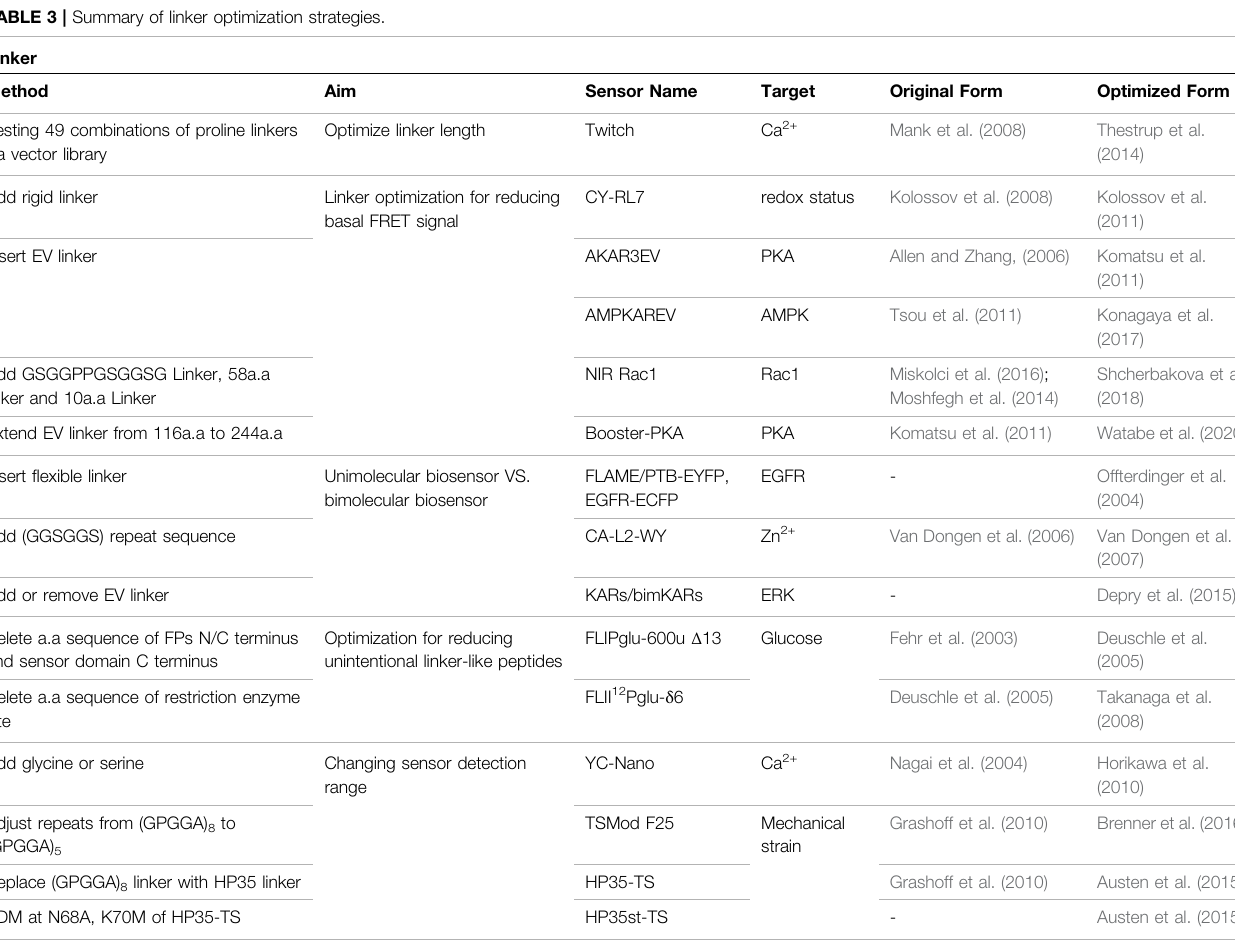
TABLE 3 | Summary of linker optimization